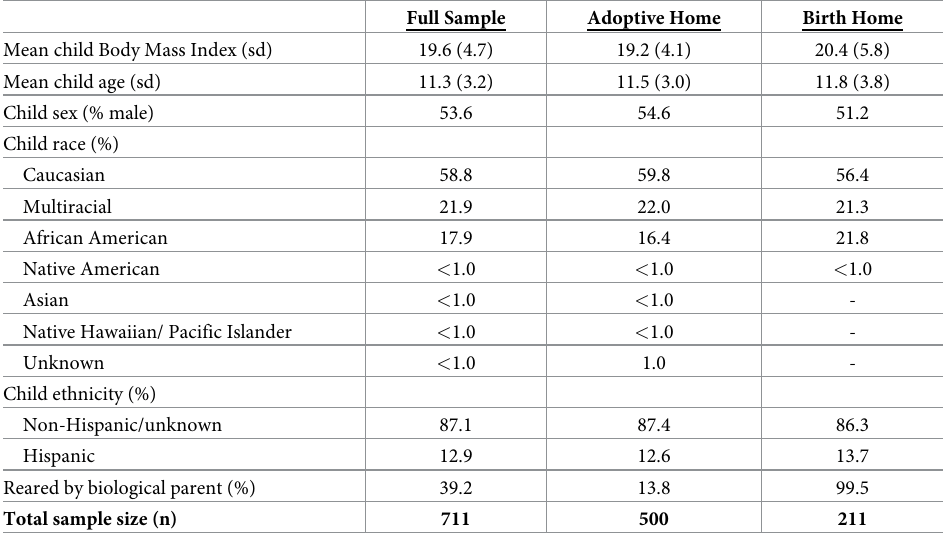
Table 1. Child descriptive statistics by home type.